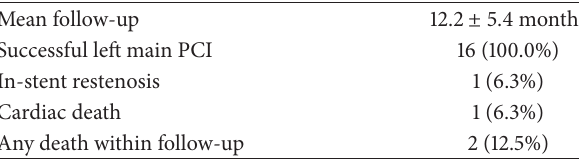
Table 2: Outcomes.